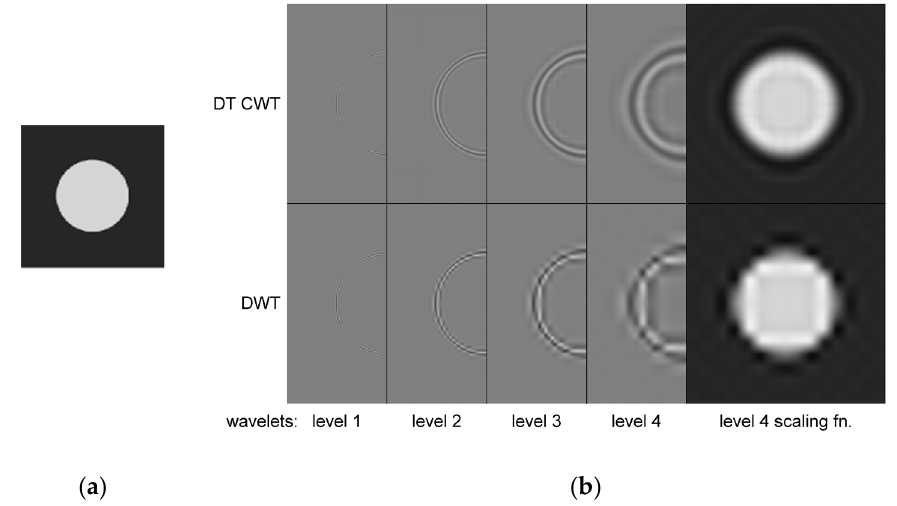
Figure 3. Shift invariance of 2D DTCWT: ( a ) Input image; ( b ) Reconstructed images.